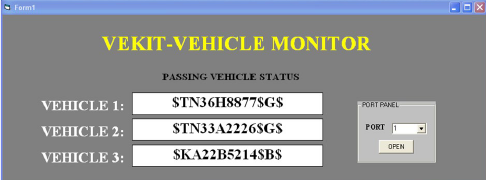
Figure 6. Parts of VEKIT prototype SU and MU